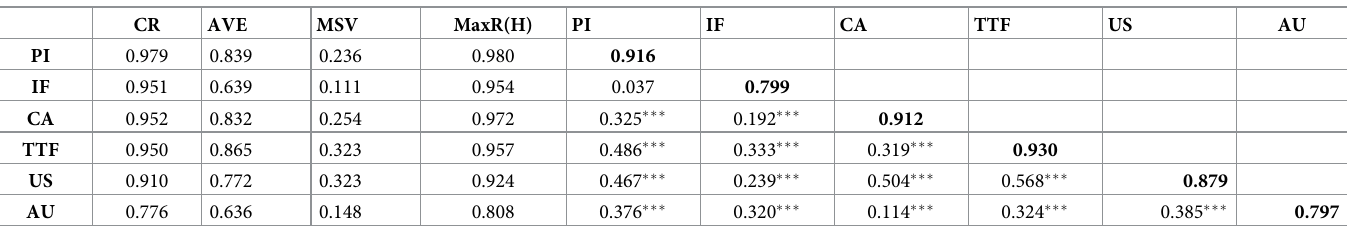
Table 4. Discriminant